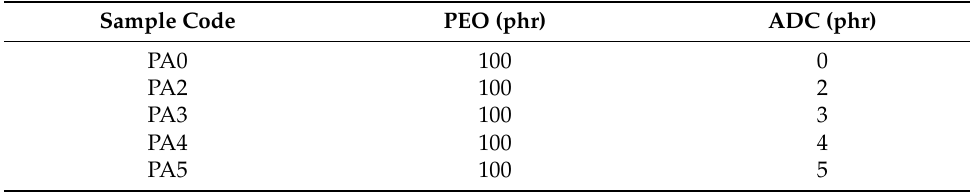
Table 1. The samples’ codes used with their